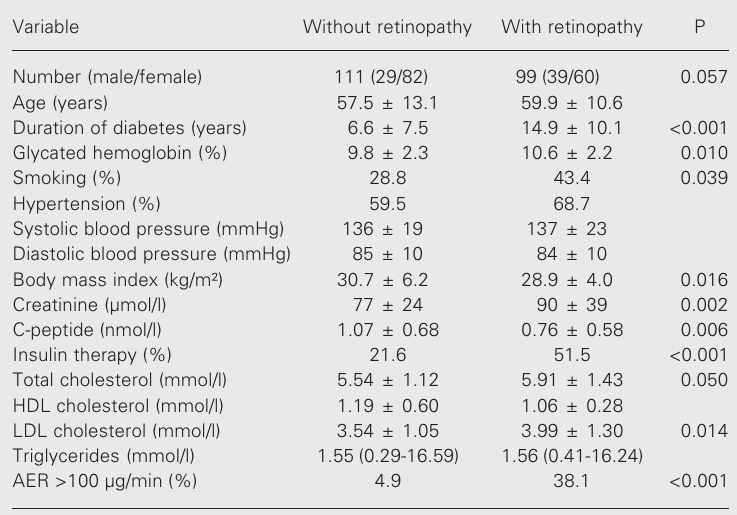
Table 1. Clinical and laboratory characteristics of patients with type II diabetes mellitus with and without diabetic retinopathy.